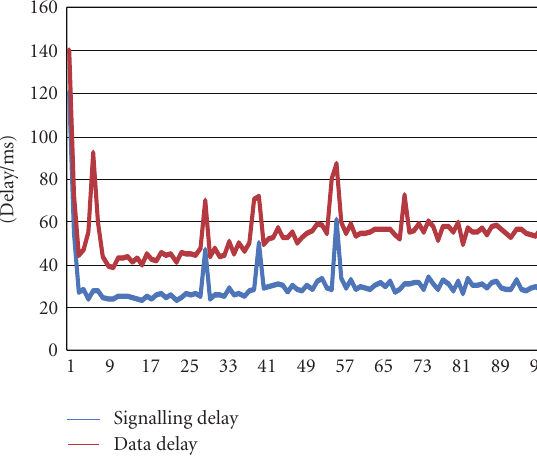
Figure 9: Session delay at 5cps.